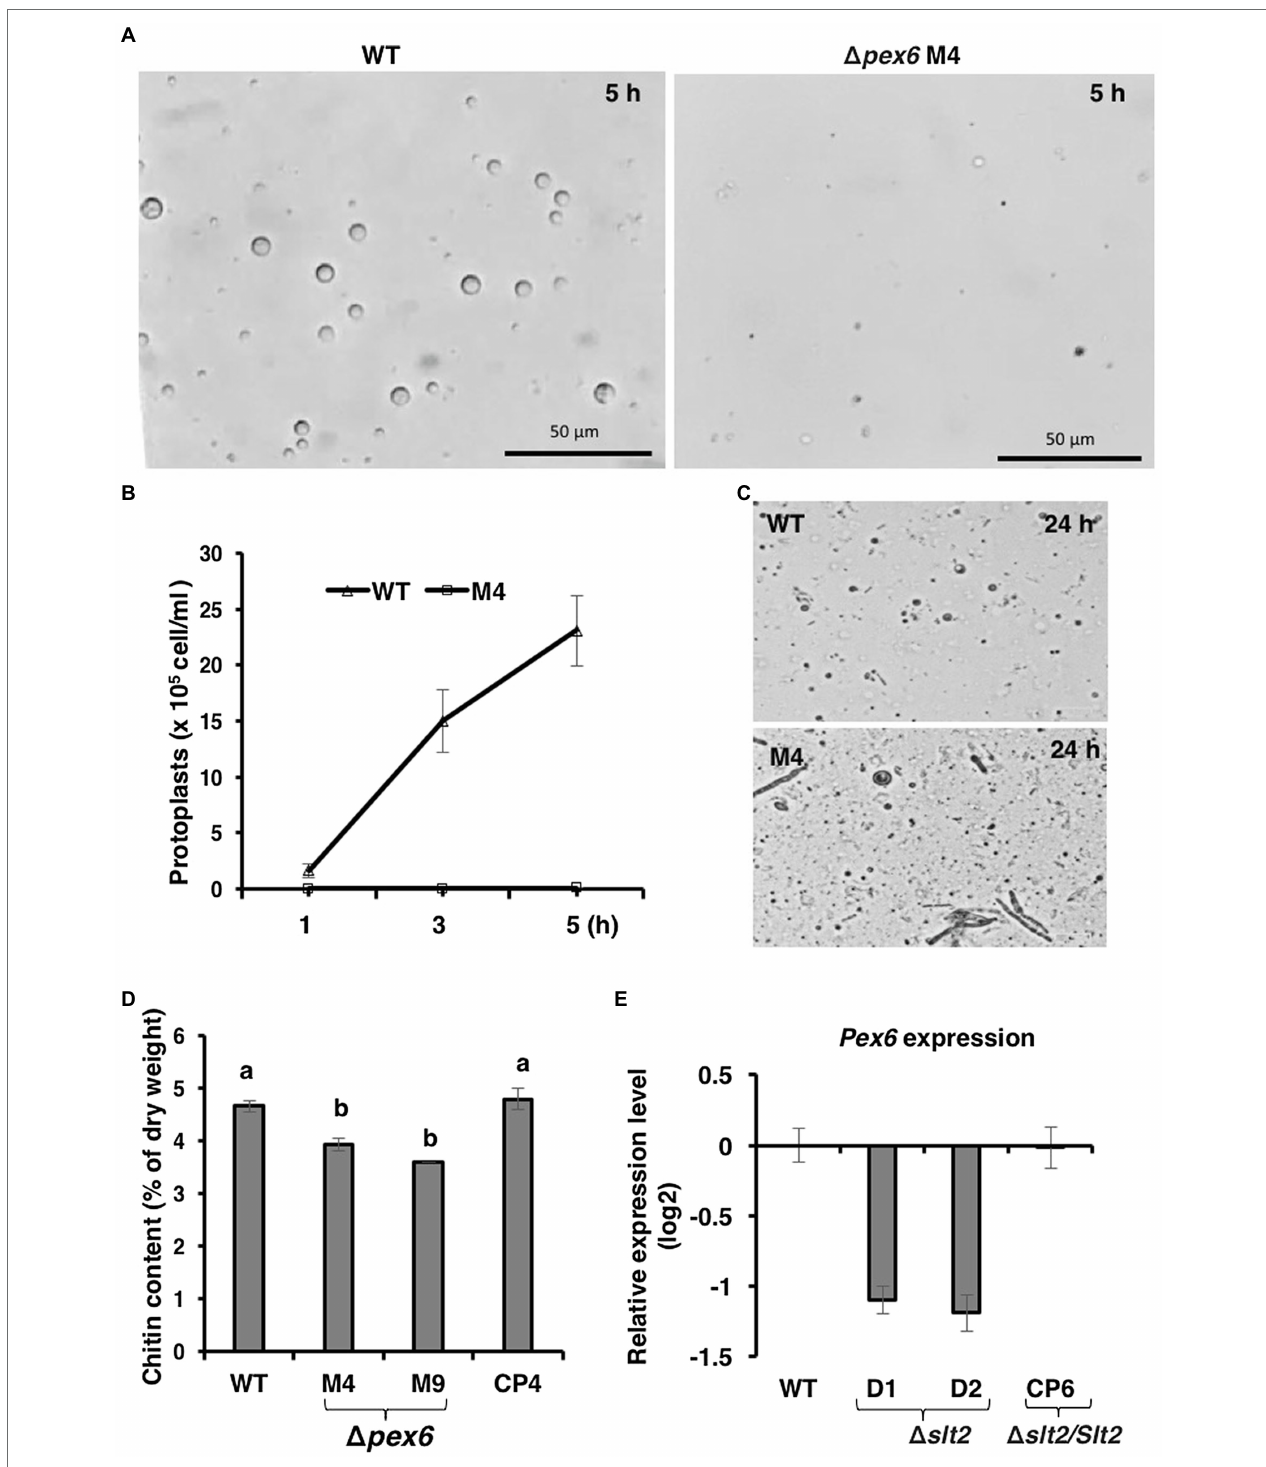
FIGURE 3 | Pex6 encoding an ATPase-associated (AAA) protein is required for cell wall integrity of A. alternata . (A) Release of fungal protoplasts from the wild-type (WT) and the Δ pex6 M4 strains after being treated with cell wall-degrading enzymes (CWDEs) for 5 h. (B) Quantitative analysis of protoplast release from WT and M4 over time. (C) A prolonged incubation (24 h) of fungal strains with CWDEs. (D) Comparison of chitin among WT, two Δ pex6 strains (M4 and M9) and the CP4 complementation strain re-expressing a functional copy of Pex6 in M4. Significance of difference between means was analyzed using Tukey’s HSD post-hoc test ( p ≤ 0.05). Means ( n = 100) followed by the same letters are not significantly different. (E) Quantitative real-time (qRT)-PCR analysis of the Pex6 transcripts in WT, two Δ slt2 mutants (D1 and D2), and the CP6 complementation strain re-expressing a functional copy of Slt2 in